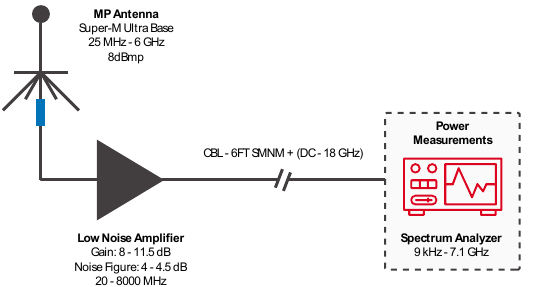
Figure 1. Experimental configuration for measuring spectral occupancy.